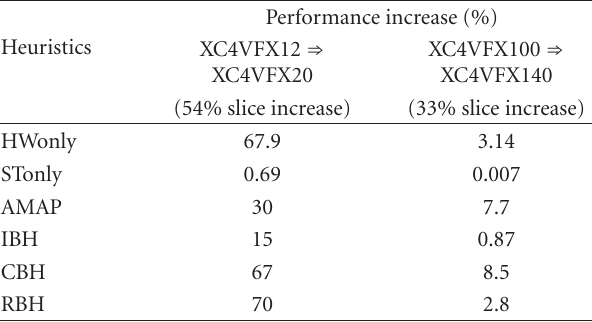
Table 2: The performance increase in di ff erent heuristics with the corresponding area increase in the FPGA. There is no linear relation between the area and the corresponding performance improvement.